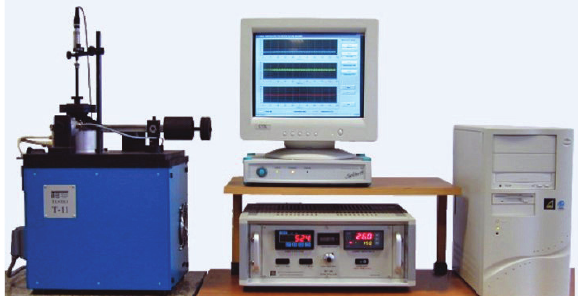
Figur e 2. Photograph of the T-11 tribotester